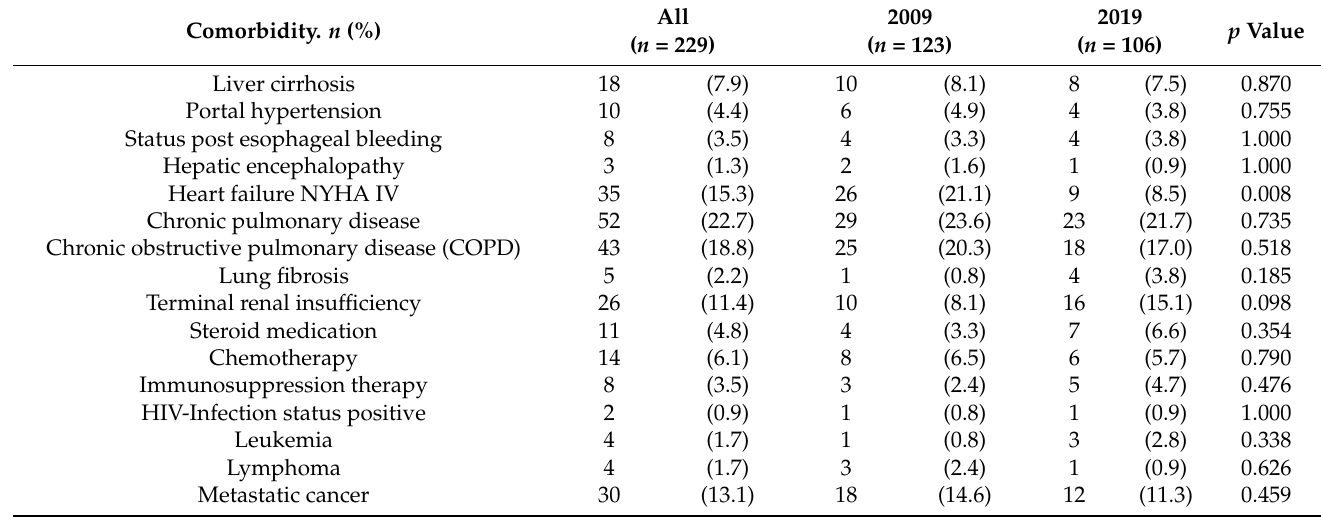
Table 2. Patient comorbidities.